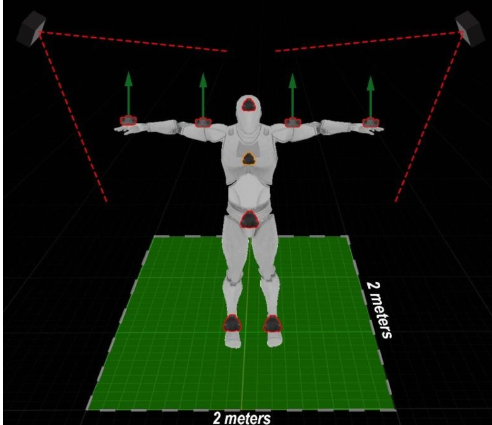
Figure 4. System and sensor layout view: At least 2 m should be made available for unrestricted movements of a subject.